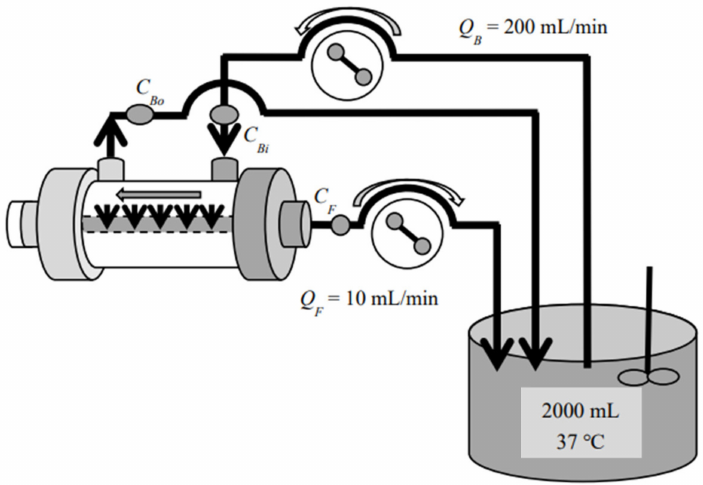
Figure 2. Test circuit for the backward (Out-to-In) ultrafiltration